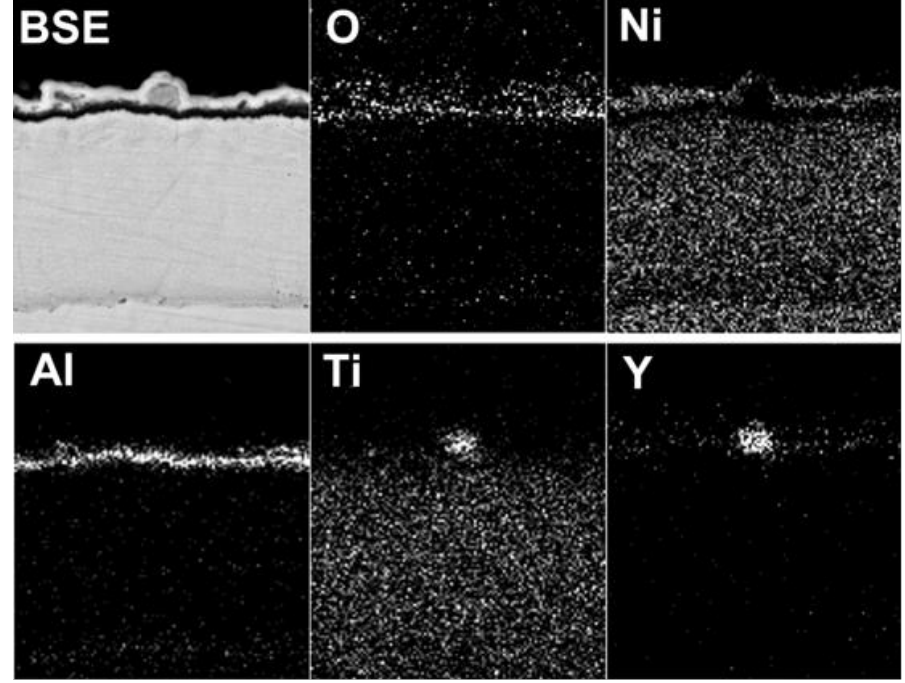
Figure 5. XRD Elemental mapping of the Y-enriched particle formed on the K38-0.5Y coating surface at 900 